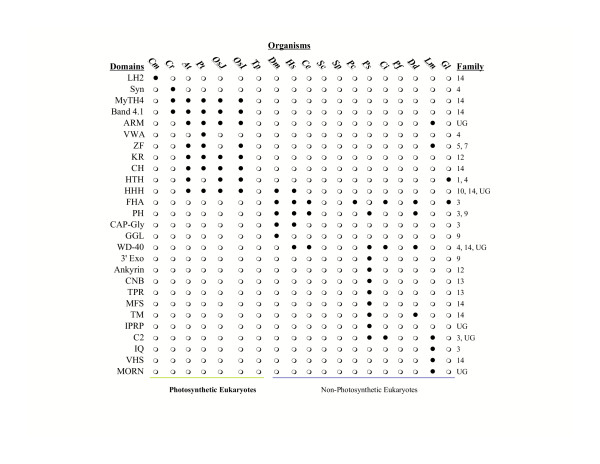
Distribution of domains found within kinesins of 19 species. Schematic showing the presence or absence of particular domains and which families these domains are found in across the 19 species sampled. Species are listed horizontally across the top of the figure with the various domains listed vertically. Presence of a domain is indicated by a solid circle and its absence by a hollow circle. LH2, Lipoxygenase; Syn, N-terminal Syntaxin; MyTH4, Myosin Tail Homology 4; ARM, Armadillo; VWA, Von Willebrand Factor, Type A; ZF, Zinc finger; KR, Kinesin-Related; CH, Calponin Homology; HTH, Helix-Turn-Helix; HHH, Helix-Hairpin-Helix; FHA, Fork Head Associated; PH, Pleckstrin homology; CAP-Gly, Glycine rich domain found in Cytoskeleton Associated Proteins (CAPs); GGL, G-protein gamma motif like; WD-40, A 40 amino acid repeat motif with W and D dipeptides at the terminus; 3' Exo, 3' Exoribonuclease; CNB, Cyclic Nucleotide Binding; TPR, Tetratricopeptide repeat; MFS, Major Facilitator Superfamily; TM, Transmembrane; IPRP; Inositol polyphospate related phosphatase; C2, Protein kinase C conserved region 2; VHS, Domain present in Vps-27, Hrs, STAM; MORN, Membrane occupation and recognition nexus. In T. pseudonana, most kinesins are short (Table 7 and Figure 12), which could be due to poor quality of the gene models. Hence, it is possible that they contain additional domains. For full names of species see Fig. 1 legend.